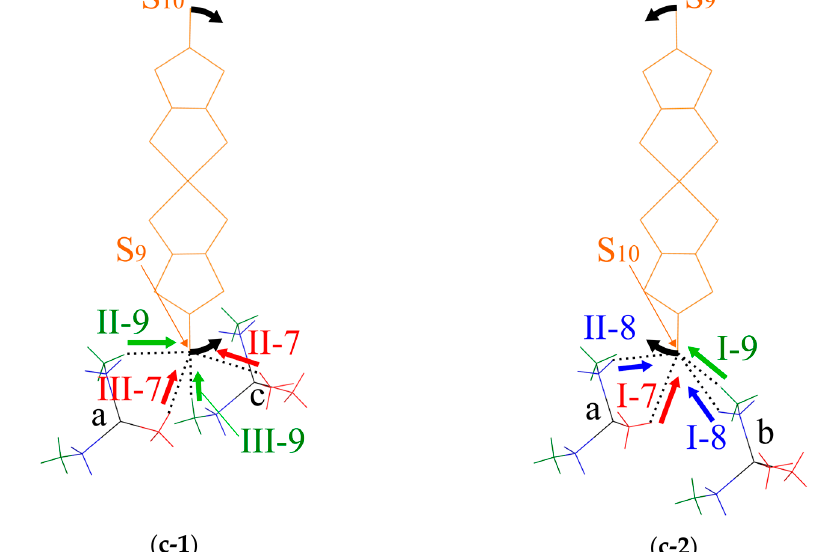
Figure 9. Schematic illustration of the short S · · · H-C contacts. ( a ) Oblique view. ( b ) End-on projections of the dimer arrangement. ( c ) Views along the vector connecting the two Pd atoms in the dimer, ( c-1 ) shows the short S · · · H-C contacts between the S 9 atom in the lower Pd(dmit) 2 molecule in ( b ) and cations a and c , ( c-2 ) shows the S · · · H-C short contacts between the S 10 atom in the upper Pd(dmit) 2 molecule in ( b ) and cations a and b : black arrows indicate the direction of the arch-shaped distortion with a positive Φ value. The red, green and blue arrows indicate the directions of repulsive S · · · H-C7, S · · · H-C8, and S · · · H-C9 interactions,